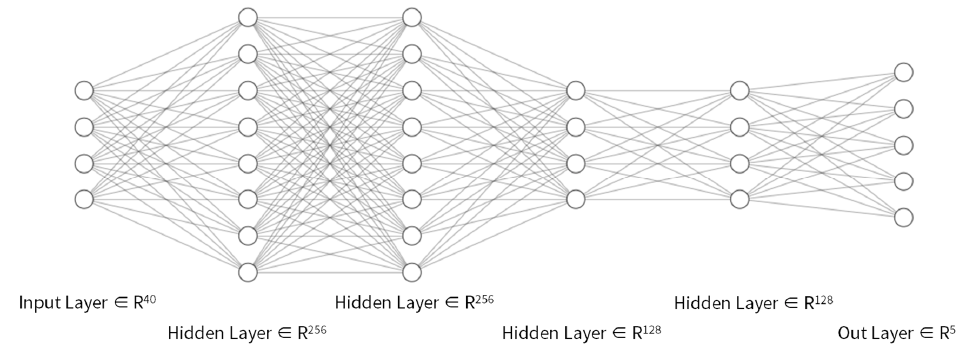
Figure 5. Network structure.